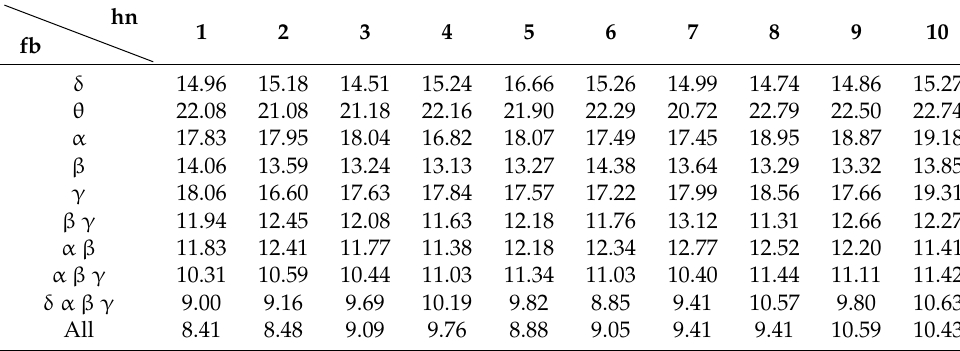
Table 8. The percentage of successful impostor attacks for the first scenario.